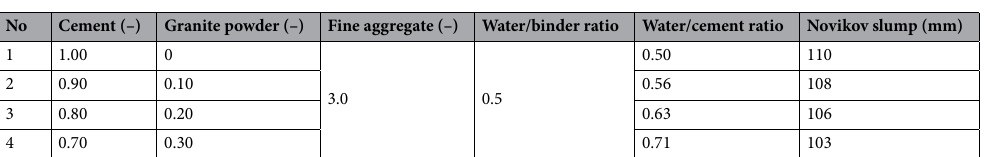
Table 2. Mixture proportions used in this study.